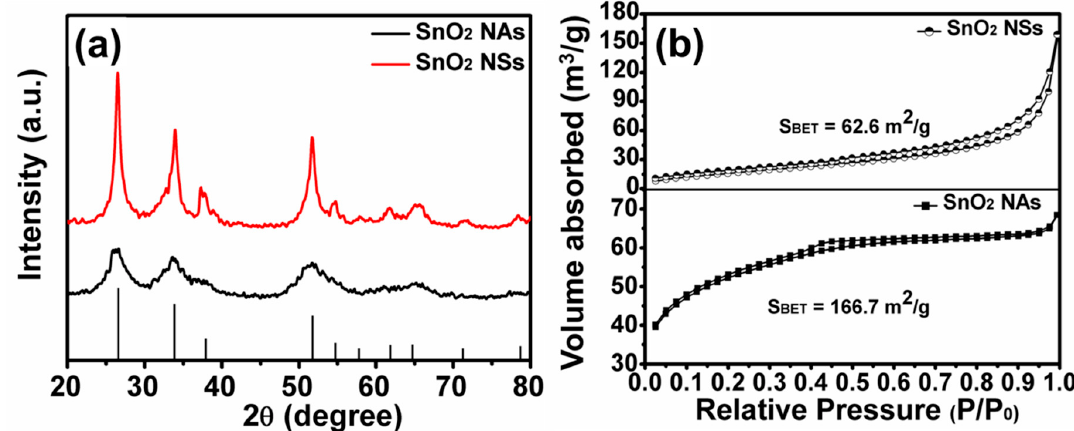
Figure 1. ( a ) XRD patterns of the as-prepared SnO 2 NAs and SnO 2 NSs. ( b ) Nitrogen adsorption and desorption isotherms of SnO 2 NAs and SnO 2 NSs. Vertical bars below represent the standard XRD pattern of SnO 2 .